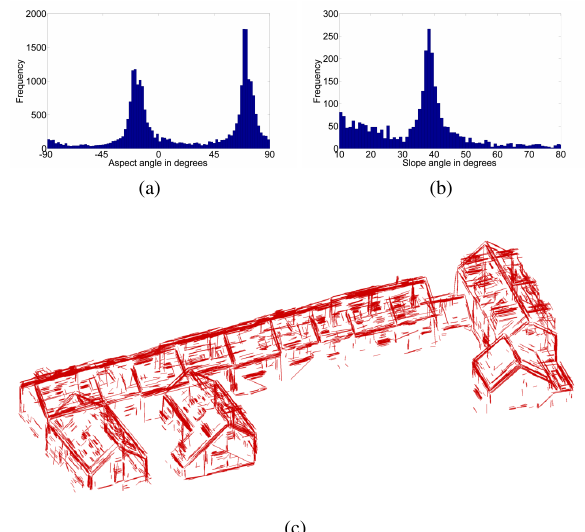
Figure 2. Filtering 3D line segments (a) Orientation of line segments in the xy-plane (with superimposed results of maxima detection) (b) 3D Orientation of line segments against the z-plane (with superimposed results of maxima detection) (c) Final selection of 8891 3D line segments